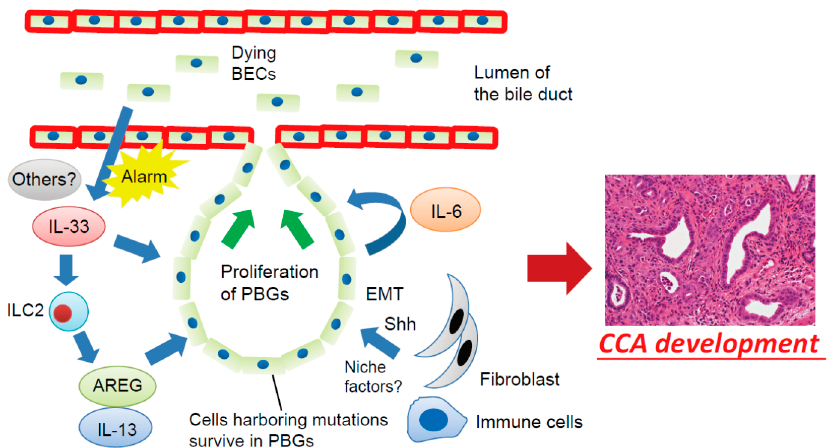
Figure 2. Proposed mechanisms involving the BEC injury-induced regenerative inflammatory response and cholangiocarcinogenesis. Dying or damaged luminal surface BECs release interleukin (IL)-33 and other alarmins to induce regenerative responses by PBGs. IL-33 promotes proliferation of PBGs, directly or indirectly, through activation of autocrine IL-6 signaling or ILC2, which produces effector cytokines and growth factors, such as IL-13 and amphiregulin (AREG). However, cells harboring mutations survived in the PBGs; therefore, the regenerative response to biliary injury resulted in development of cholangiocarcinoma (CCA) from PBGs. During this process, a microenvironment in the PBGs supports cancer-initiating cells in the form of cell–cell contacts and/or secreted factors such as Sonic Hedgehog (Shh) released from surrounding fibroblasts, although the precise mechanisms remain poorly understood. EMT—epithelial–mesenchymal